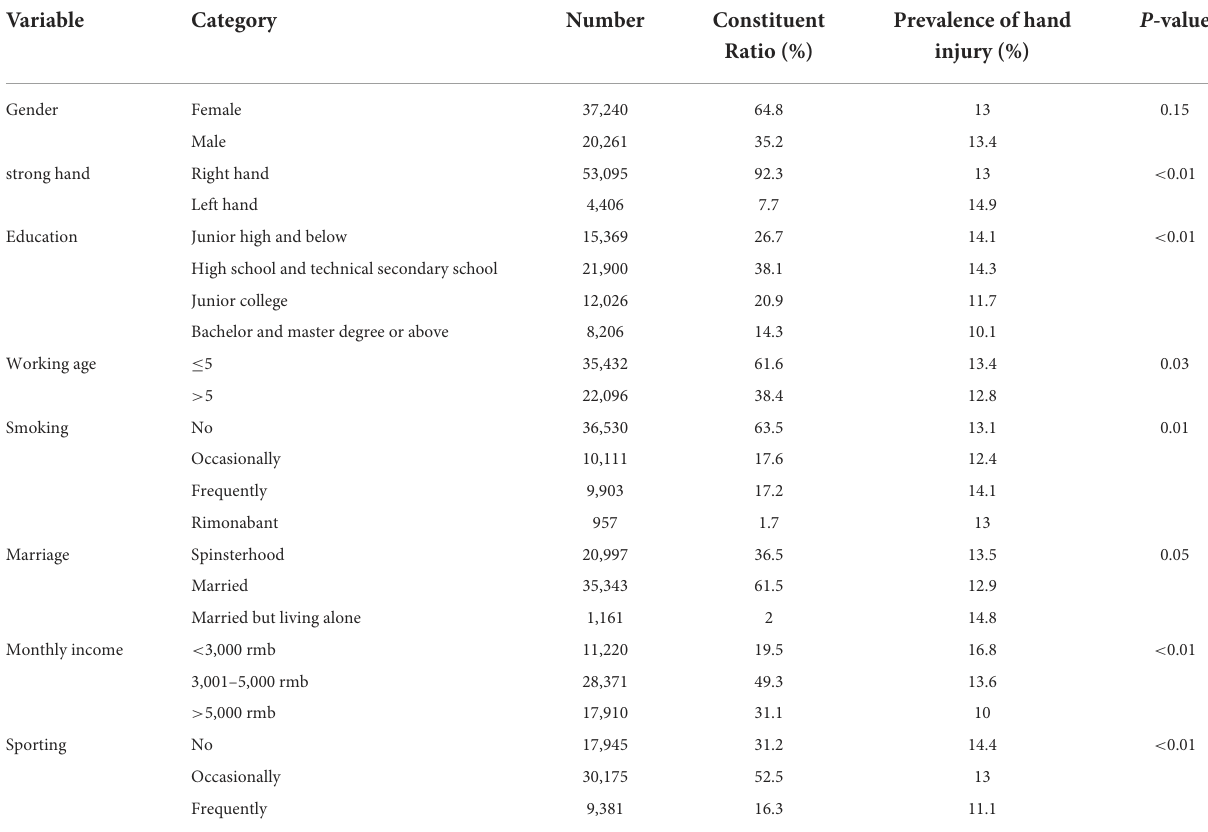
TABLE 1 Wrist injury rate under different characteristics.